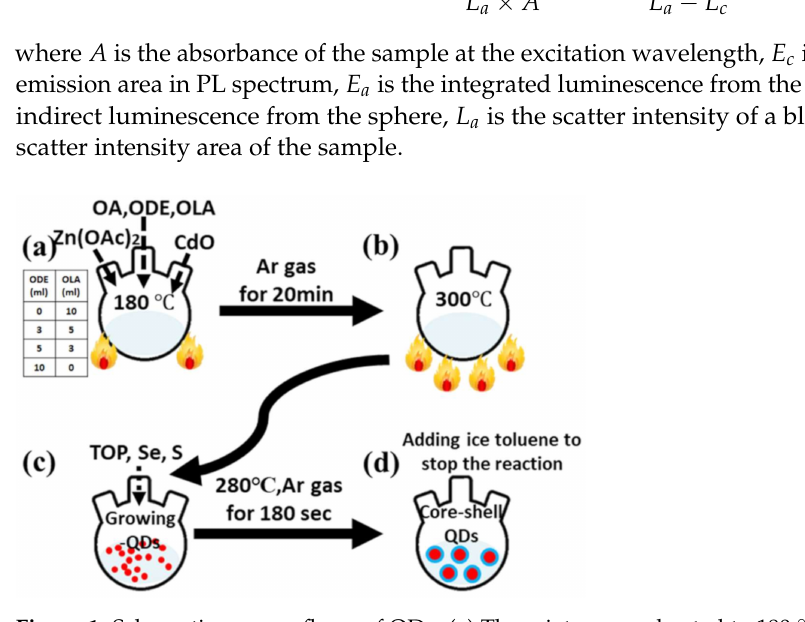
Figure 1. Schematic process flows of QDs. ( a ) The mixture was heated to 180 ◦ C and degassed by Ar for 20 min, ( b ) the temperature was increased to 300 ◦ C, ( c ) the TOP, Se and S were injected into the four-neck flask by using a syringe, and ( d ) rapidly cooled down by adding ice toluene to stop the